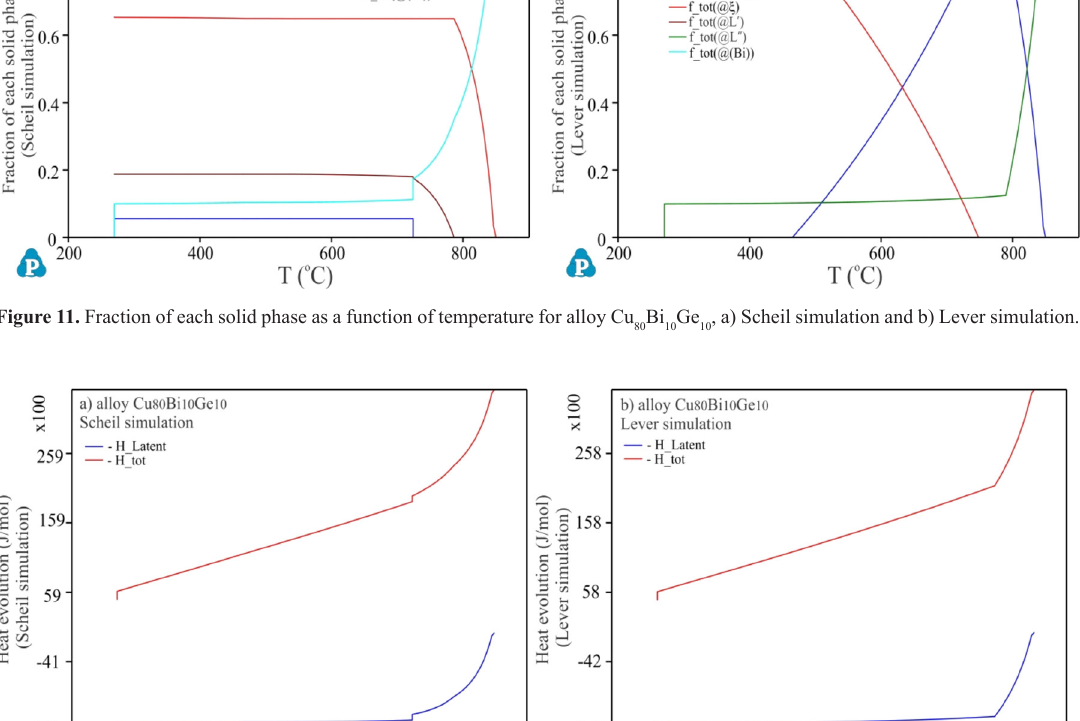
Figure 12. Heat evolution as a function of temperature for alloy Cu